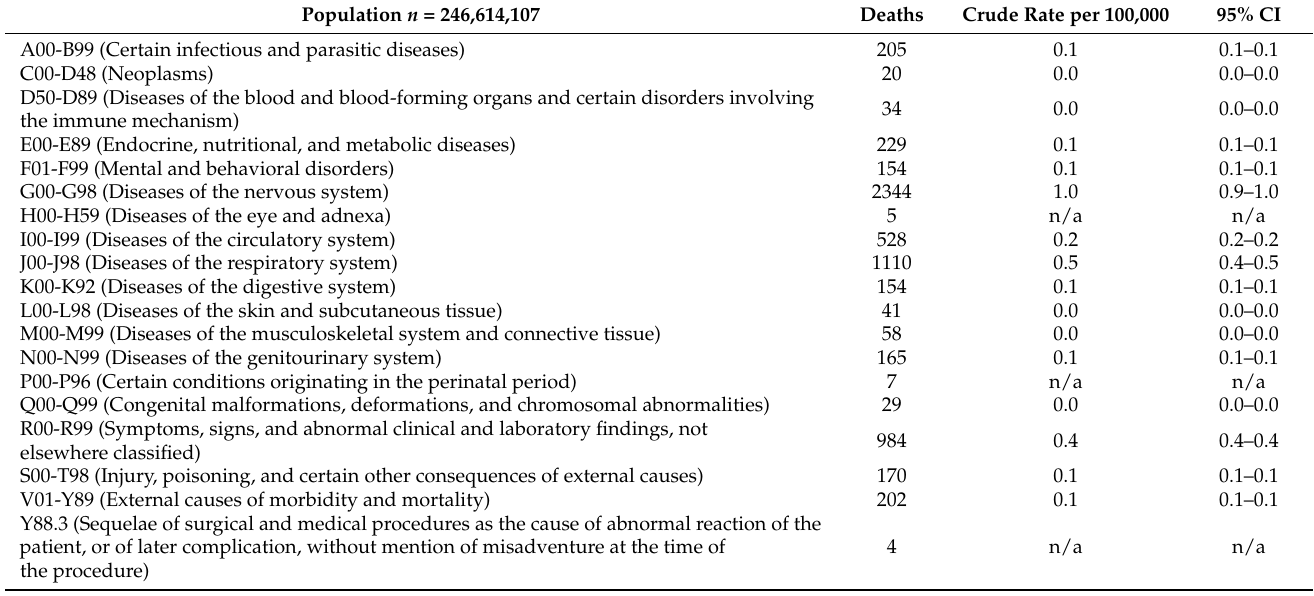
Table 3. Adults with cerebral palsy who died in 2019, with the underlying cause of death listed as “cerebral palsy”, and other multiple causes of